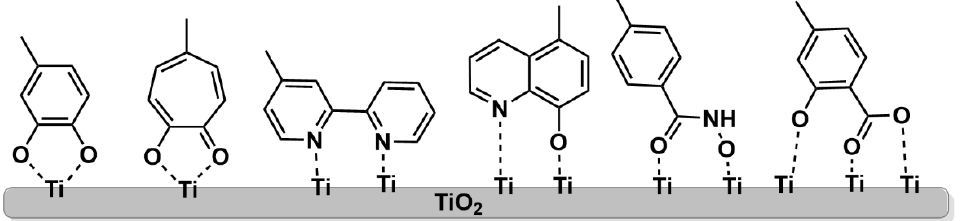
Figure 14. Postulated modes of binding of catechol [74], tropolone [76], bipyridyl [67], 8-hy- droxyquinoline [75], hydroxamic acid [77] and salicylic acid [78] anchoring groups on TiO 2